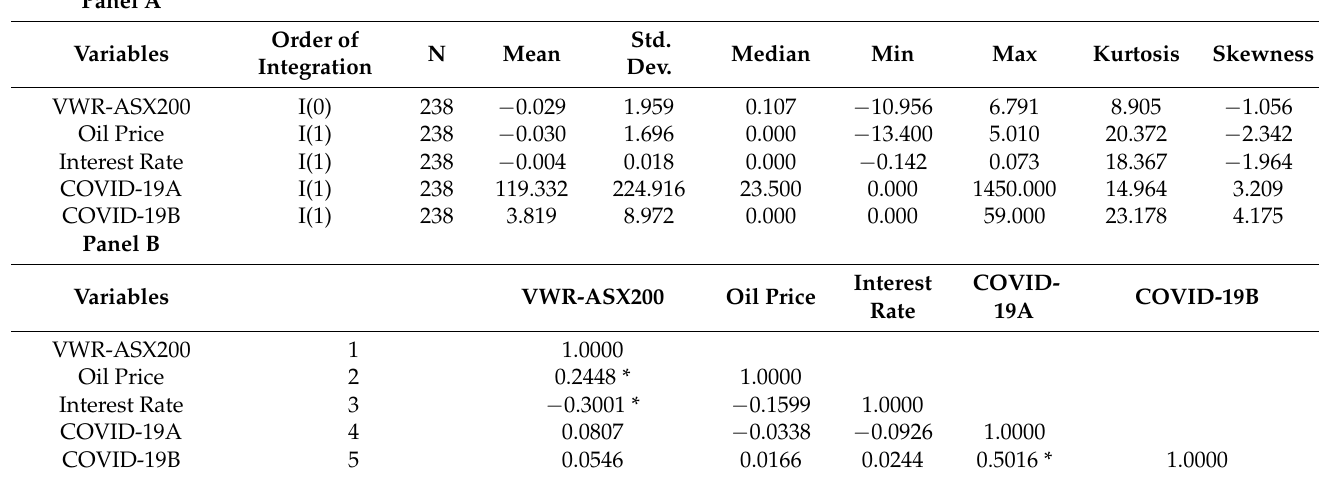
Table 3. Panel A shows the summary statistics for the variables used in the specifications. We use data of 197 stocks listed on S&P/ASX200 from 27 January 2020 to 30 December 2020 to examine the effect of COVID-19 on Australian stock returns and their volatility. VWR-ASX200 is the value-weighted return of 197 stocks listed in S&P/ASX200 at level, Oil Price is the international crude oil price to the order I(1), Interest rate is Australian one-month interbank interest rate to the order I(1), COVID-19A represents the total number of confirmed COVID-19 cases in Australia to the order I(1), COVID-19B represents the total number of deaths in Australia due to COVID-19 to the order I(1). Meanwhile, COVID-19C is a dummy variable depicting the negative news, and it takes a value of 1 from 24 February 2020 to 22 March 2020, otherwise